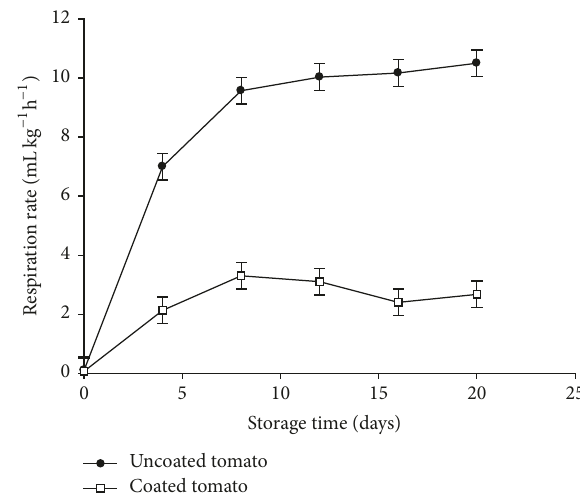
Figure 6: Influence of guar gum coating on the respiration rate of Roma tomatoes during a 20-day storage period at ambient temperature ( 22 ± 2 ∘